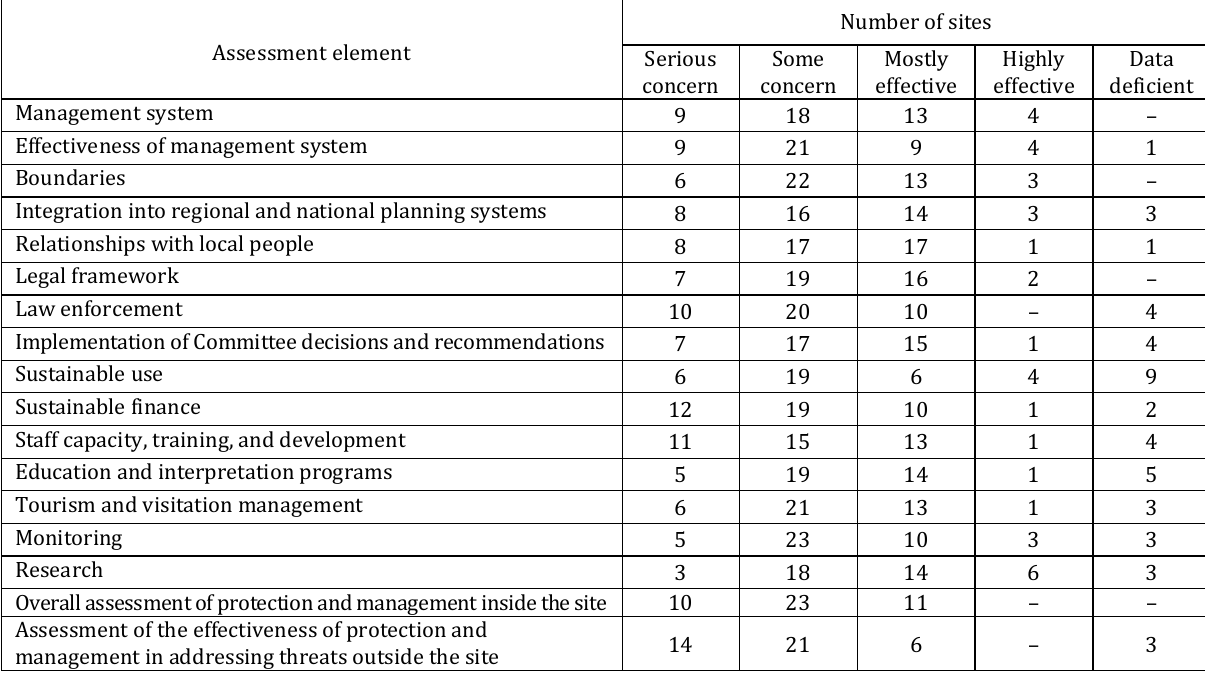
Table 5. Effectiveness of protection and management in natural and mixed World Heritage sites in Africa